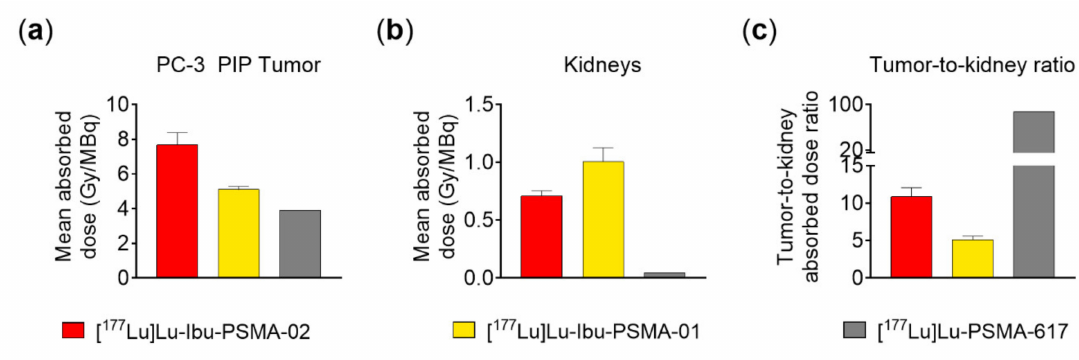
The graphs show dosimetry results of [ 177 Lu]Lu-Ibu-PSMA-02 in comparison to [ 177 Lu]Lu-Ibu-PSMA-01 and [ 177 Lu]Lu-PSMA-617. ( a ) Values representing the mean absorbed doses of the PC-3 PIP tumor; ( b ) mean absorbed kidney doses, and ( c ) the tumor-to-kidney absorbed dose ratios for [ 177 Lu]Lu-Ibu-PSMA-02, [ 177 Lu]Lu-Ibu-PSMA-01 and [ 177 Lu]Lu-PSMA-617 [19]. Data for [ 177 Lu]Lu-PSMA-617 adapted from Müller et al. 2019 Eur J Nucl Med Mol Imaging 46: 1919